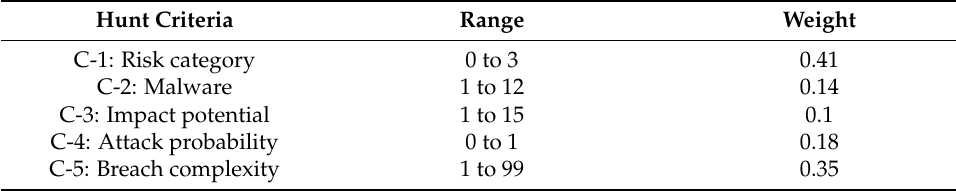
Table 3. Decision making parameters.